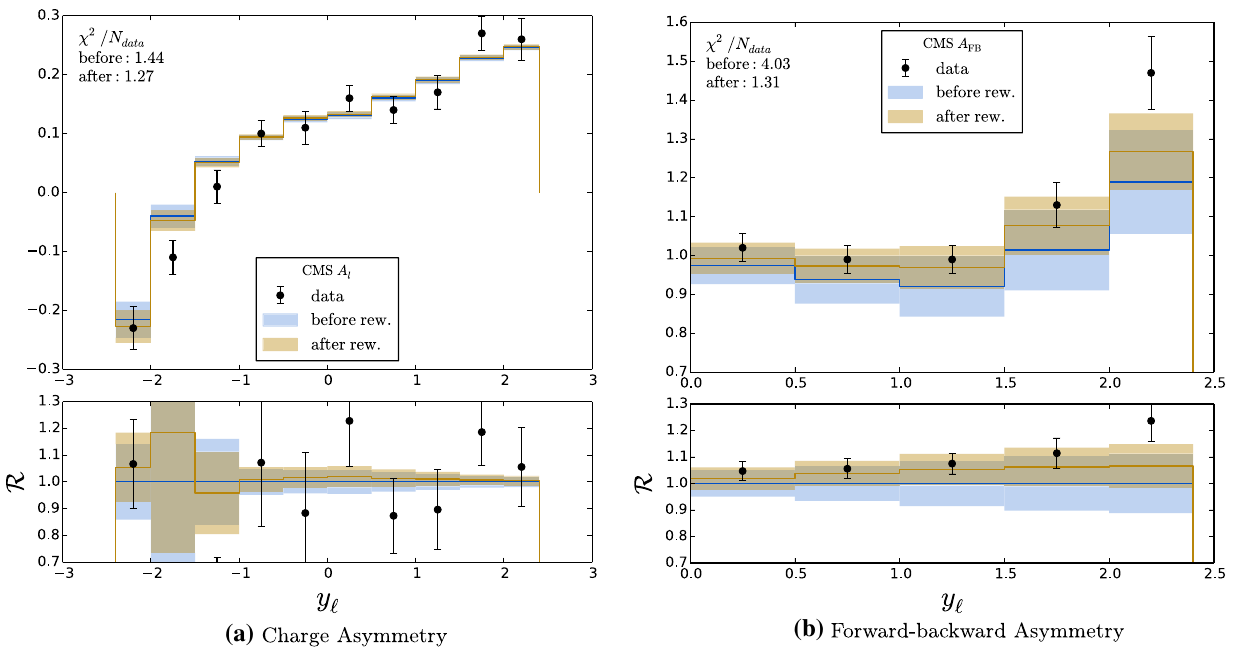
Fig. 21 Comparison of data and theory before and after the reweighting procedure using the charge asymmetry ( left ) and the forward–backward asymmetry ( right ) from W ± production data by CMS [4]